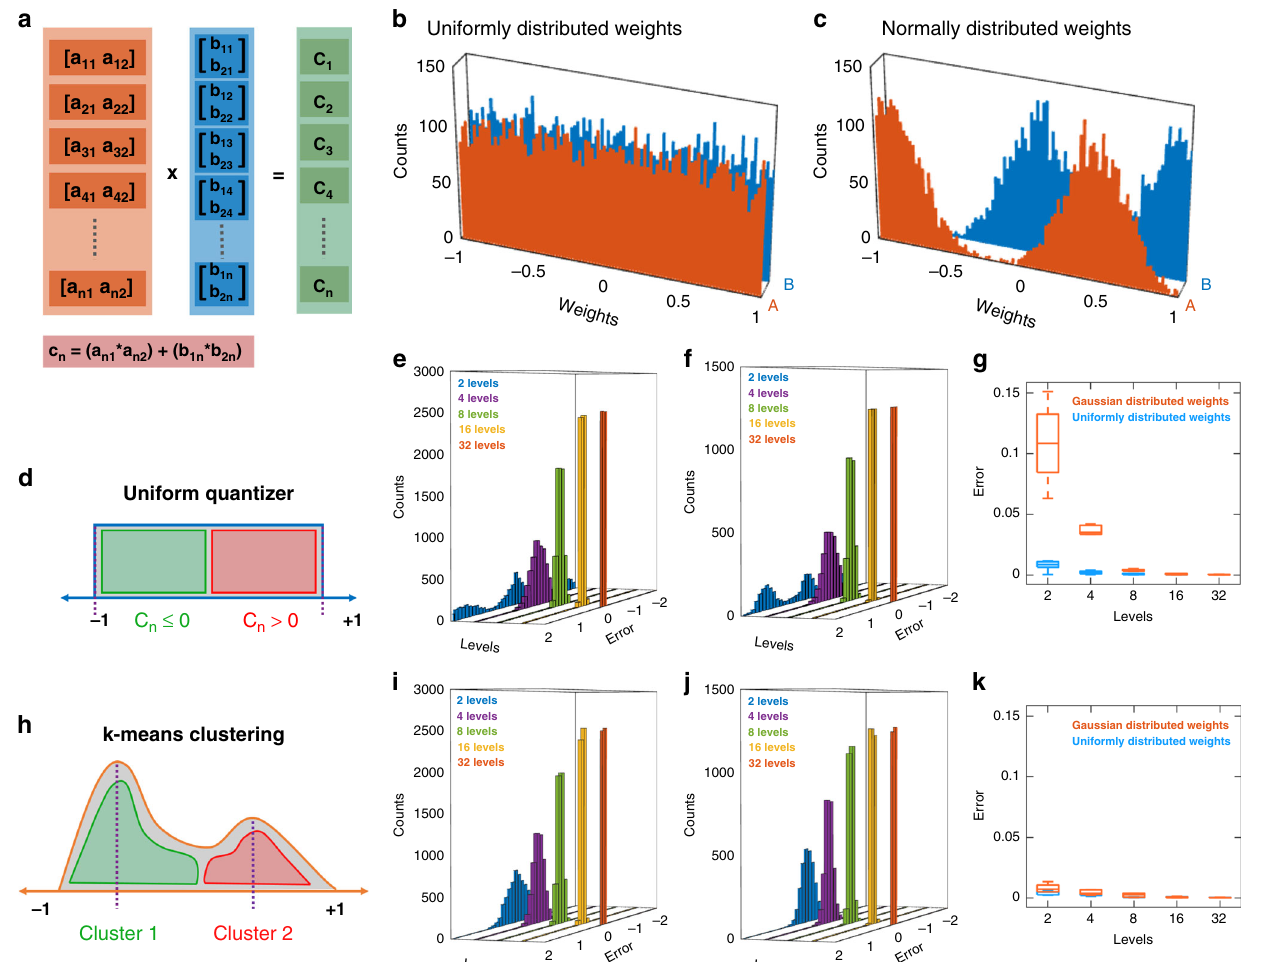
Fig. 3 Weight assignment using uniform distribution and k -means clustering. a Data structure showing vectors A and B of sizes 1 × 2 and 2 × 1, respectively, and their product, C. Matrix elements for A and B are drawn randomly from ( b ) uniform and ( c ) Gaussian normal weight distributions in the range of [ − 1, 1]. d Uniform quantization where the data range [ − 1, 1] is divided into N equally spaced bins. Any weight that belongs to a given bin is assigned to the analog memory value associated with that bin. The error histogram computed from (C Q – C), where the elements of C Q are the product of quantized elements from A and B (i.e., A Q and B Q ) as a function of N , when weights are drawn from ( e ) uniform and ( f ) normal distributions, corresponding to ( b ) and ( c ), respectively. g Box plot of the error in ( e ) and ( f ), which shows monotonic decrease as N increases. Also, for similar N , the error is signi fi cantly higher for normally distributed weights when compared to uniformly distributed weights. h The schematic of k -means clustering, which is an unsupervised learning algorithm that divides the n data samples into k clusters, such that k ≤ n . The algorithm randomly chooses the centroids, calculates the distance of each point to the centroid, and, fi nally, minimizes the variance of the distance iteratively to identify the centroids. These centroids are usually located near the mean of the clusters. In k -means clustering quantization, weights in a speci fi c cluster are quantized to their respective centroids. The error histogram as a function of N when the weights are drawn from the ( i ) uniform and ( j ) normal distributions corresponding to ( b ) and ( c ), respectively. k Box plot of the error in ( i ) and ( j ), which shows signi fi cant reduction in error for both cases when compared to that shown for uniform quantization in ( g ), especially for normally distributed quantization. Figure 3h shows the schematic of k -means clus- tering, which is an unsupervised learning algorithm that divides the n data samples into k clusters, such that k ≤ n 59 . The algo- rithm randomly chooses the centroids, calculates the distance of each point to the centroid, and, fi nally, minimizes the variance of the distance iteratively to identify the centroids. These centroids are usually located near the mean of the clusters. In k -means clustering based quantization, weights in a speci fi c cluster are quantized to their respective centroids. Figure 3i, j, respectively, show the error histogram as a function of N when the weights are drawn from the uniform and the normal distributions corre- sponding to Fig. 3b, c and are quantized using k -means clustering. As shown in Fig. 3k, the error decreases with increasing N . More importantly, k -means clustering offers better accuracy compared